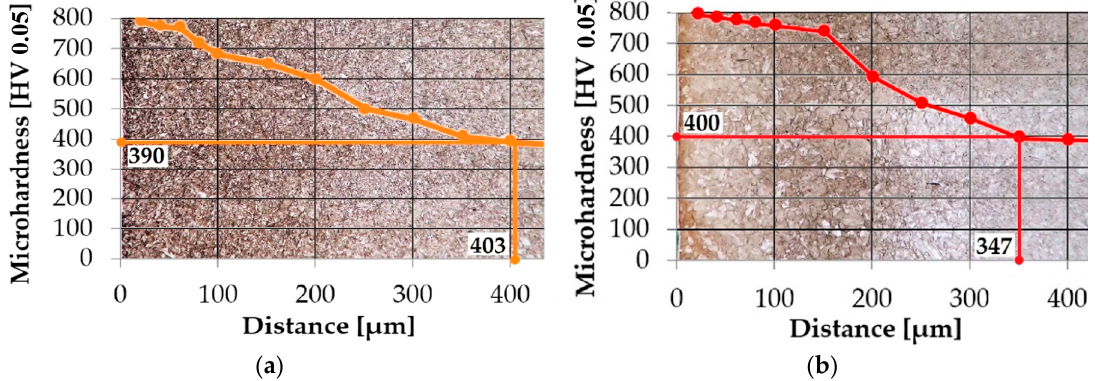
Figure 2. Profiles of microhardness with appropriate microstructures in background; ( a ) steel equivalent 42CrMo4 (i.e., CSN 41 5142)–plasma nitrided on left; ( b ) steel equivalent 17Ni4CrMo (i.e., CSN 41 6720)—plasma nitrided on right; magnification of microstructure: 600×.